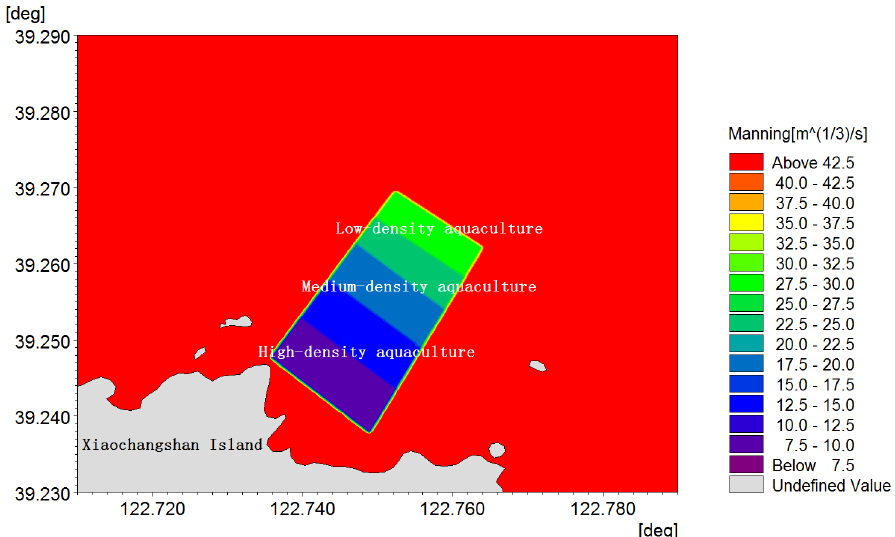
Figure 4. Distribution of Manning field after the implementation of aquaculture activities.